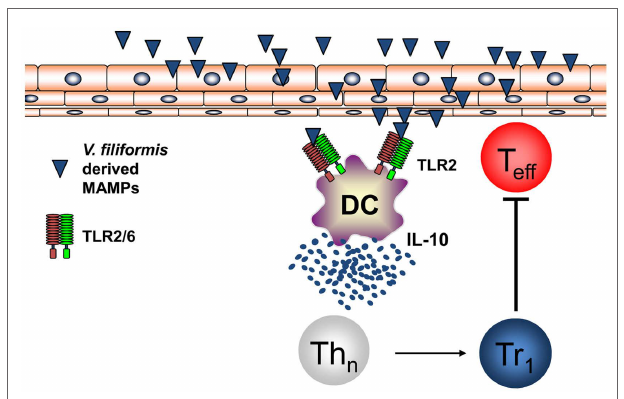
FiGURe 4 | Non-pathogenic bacterium V. filiformis- derived MAMPs induce tolerogenic DC and Tr1 cells . V. filiformis- derived MAMPs activate DC to produce IL-10 via a TLR2-dependent mechanism. DC-derived IL-10 is required to subsequently polarize naïve T helper cells into a Tr1 phenotype characterized by low IFN- γ and high IL-10 secretion. Vf-induced Tr1 cells efficiently block effector T cells (T eff ) demonstrating regulatory function for attenuating skin